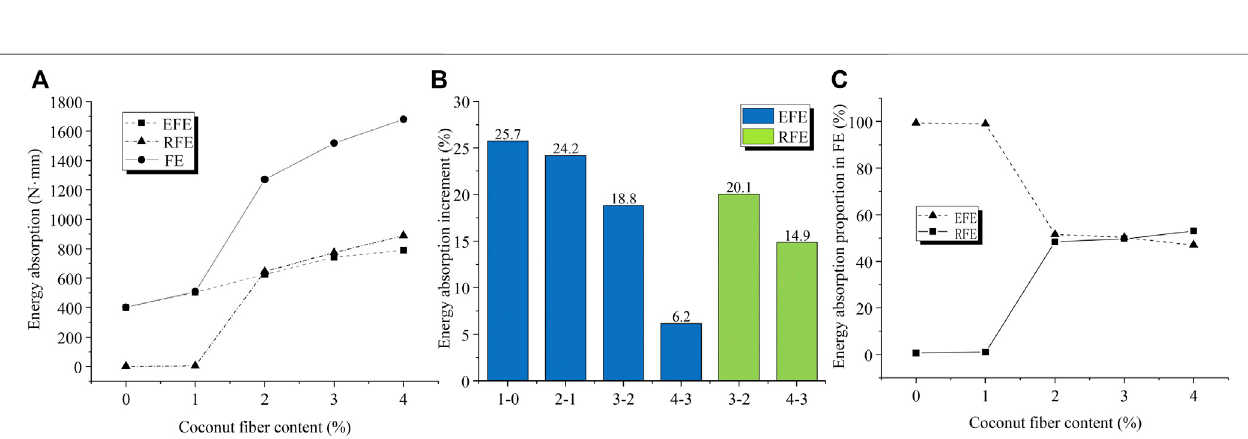
by 20.1%, from 645.4 N mm to 774.9 N mm; when CF increased